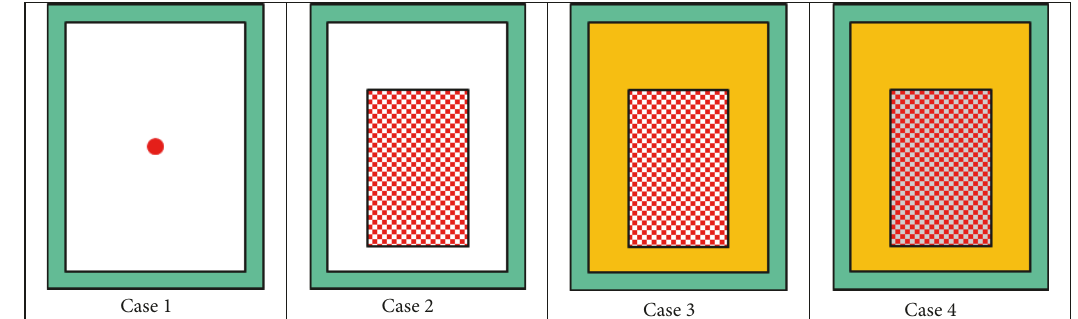
Figure 4: The four cases for the FLUKA and QAD-CGA calculation.